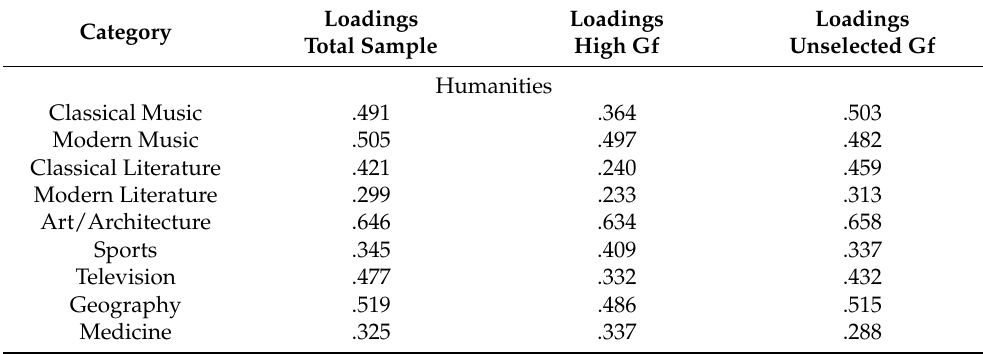
Table 8. Factor Loadings for Knowledge Categories on their respective Knowledge Domain and Loadings for Knowledge Domains on the